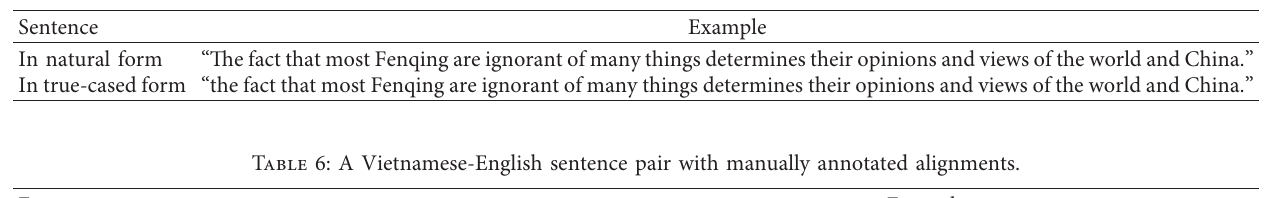
Table 6: A Vietnamese-English sentence pair with manually annotated alignments. Feature Example “the daughter took the case to court in an effort to recover the